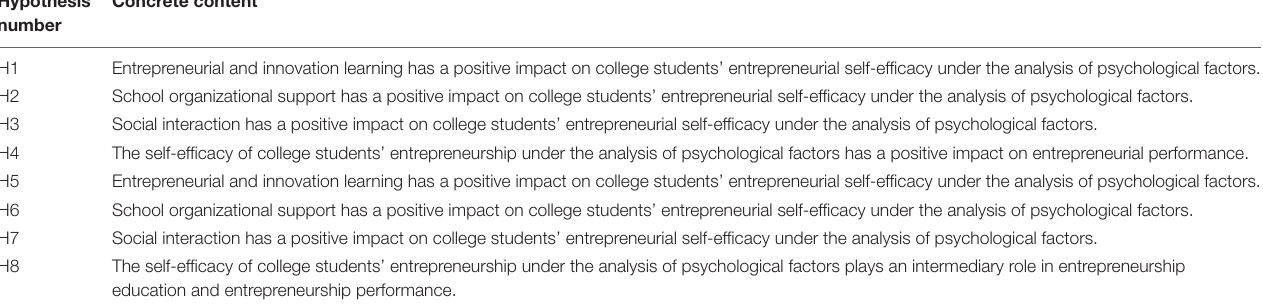
TABLE 1 | Proposal of research